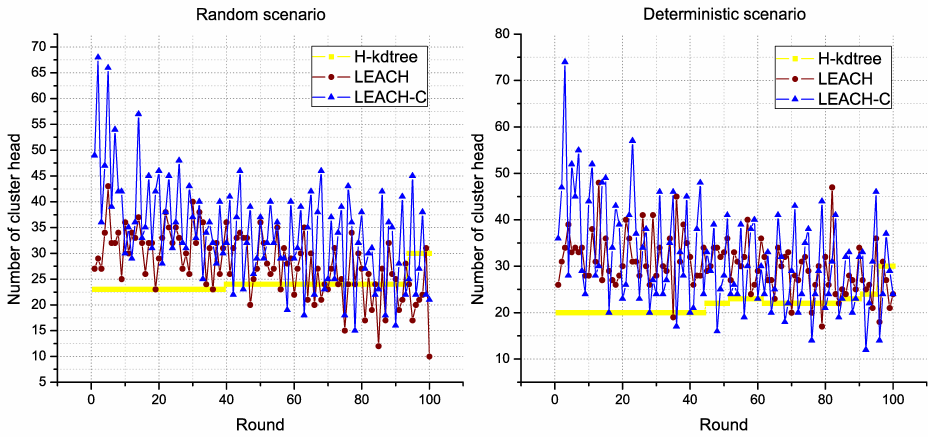
Figure 11. Cluster Head formation behavior.